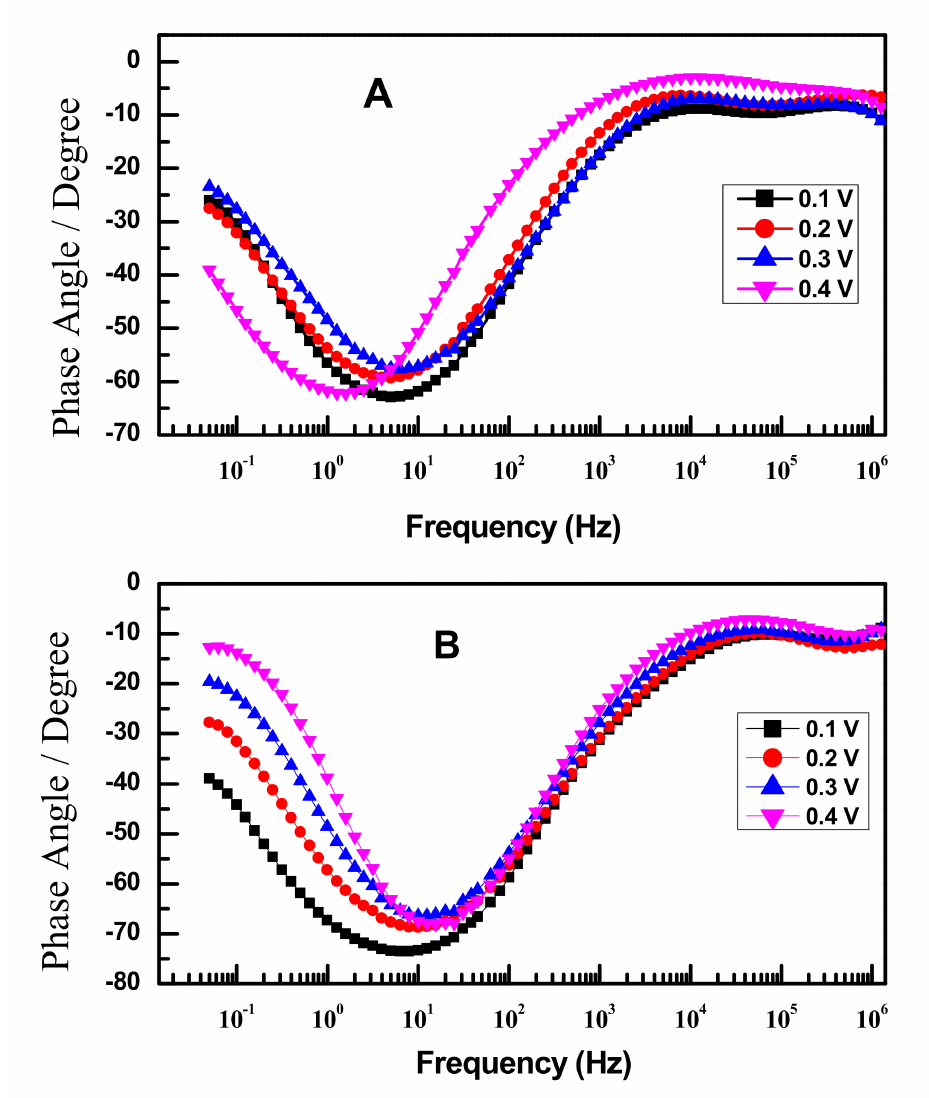
Figure 11. Bode plots measured at different potentials as indicated in ( A ) 0.06 M NaOH + 5 M